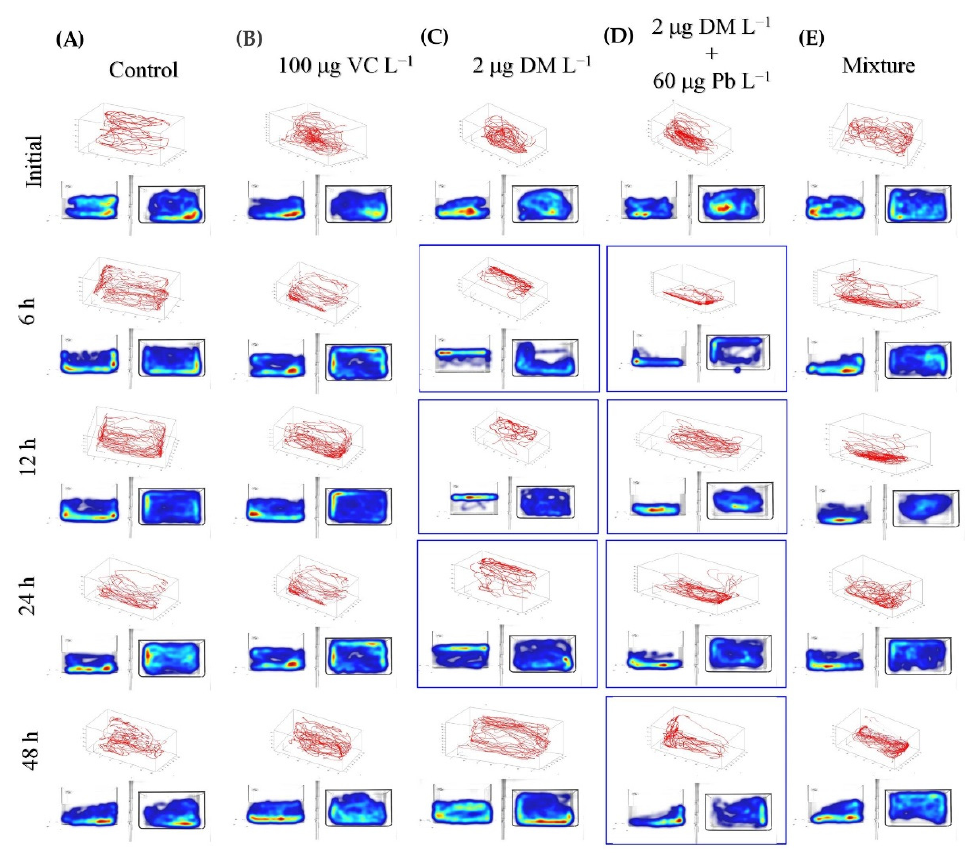
Figure 1. The 3D swim traces results for zebrafish control group ( A ) and groups treated with ( B ) 100 μ g VC L − 1 , ( C ) 2 μ g DM L − 1 , ( D ) 2 μ g DM L − 1 + 60 μ g Pb L − 1 and ( E ) mixture of VC, Pb and DM at 0, 6, 12, 24 and 48 h ( n = 15). An automated integration of traces using Track3D software results in 3D swim tracks (red color). The bottom panels show the side and top view of zebrafish in the 4 min test.